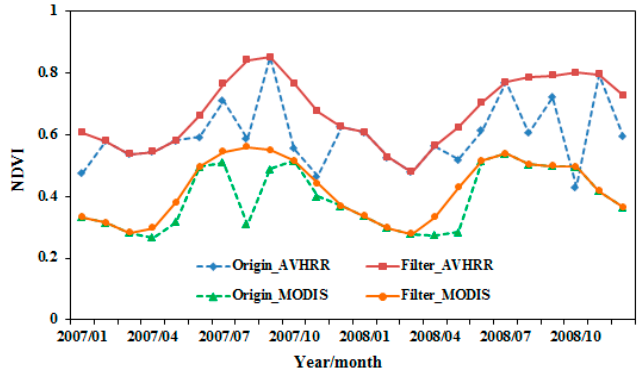
Figure 3. Effects of the MWHA method in filtering the NDVI time series. An example pixel of the MODIS and AVHRR NDVI data located at (25.32°N, 103.53°E), from 2007 to 2008.